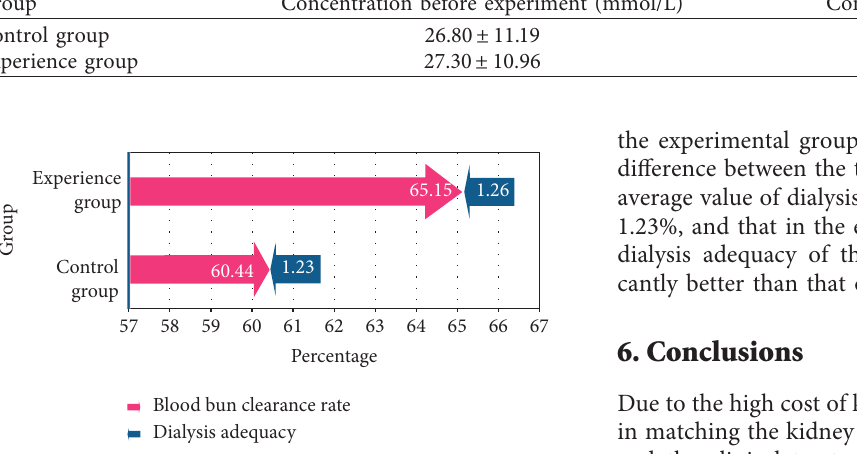
Figure 4: Comparison of blood bun clearance and dialysis ade- quacy between the two